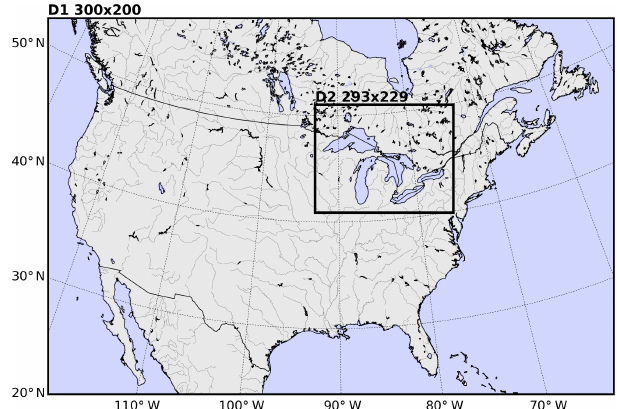
Figure 2. Simulation domains for the validation (D1) and example application experiments